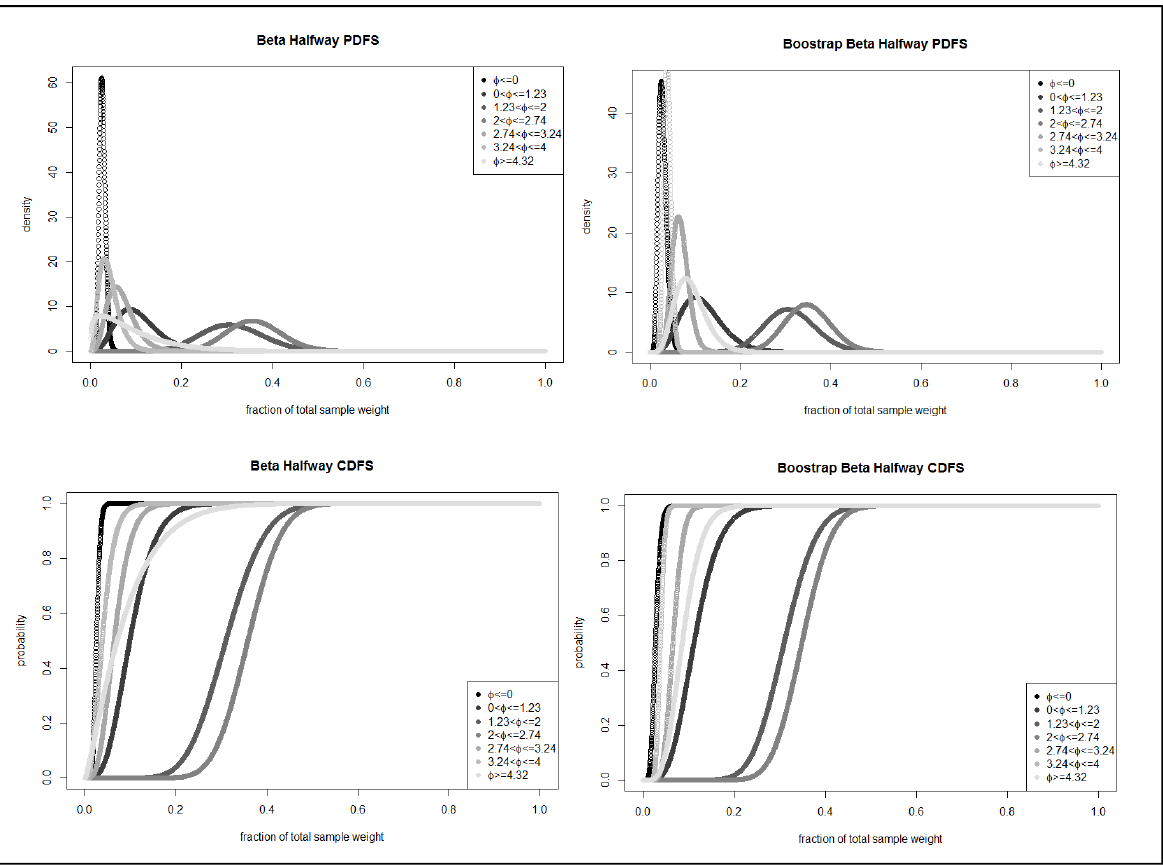
Figure 7. Halfway design setting—beta distributions of original samples along with bootstrap distributions.